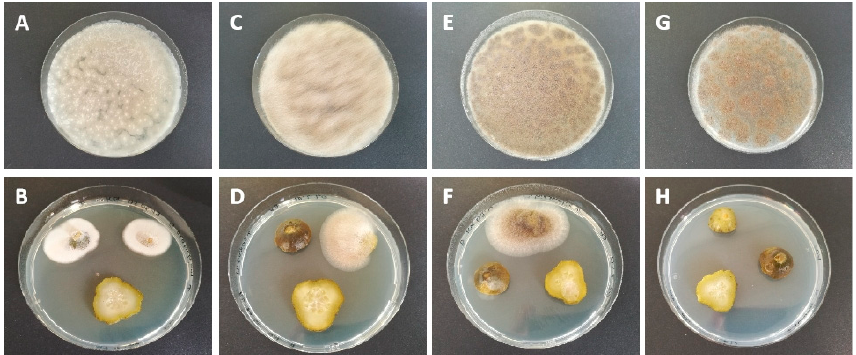
Figure 3. Fungal growth on samples taken from inoculated ready-to-sell pickle jars. Ready-to-sell pickle jars were inoculated with different fungi isolated from rotten gherkins to simulate fungal contamination and potentially induce softening of the pickles. Fungal growth was evident on the gherkin slices and vinegar broth placed on a nutrient medium after 14 days after inoculation in Galactomyces geotrichum ( A , B ), Mucor fragilis ( C , D ), and Mucor hiemalis ( E , F ). The latter grew even after 28 days after inoculation in the applied vinegar broth ( G , H ). The aim was to analyze the fungal tolerance to the acidic-salty milieu in the pickle